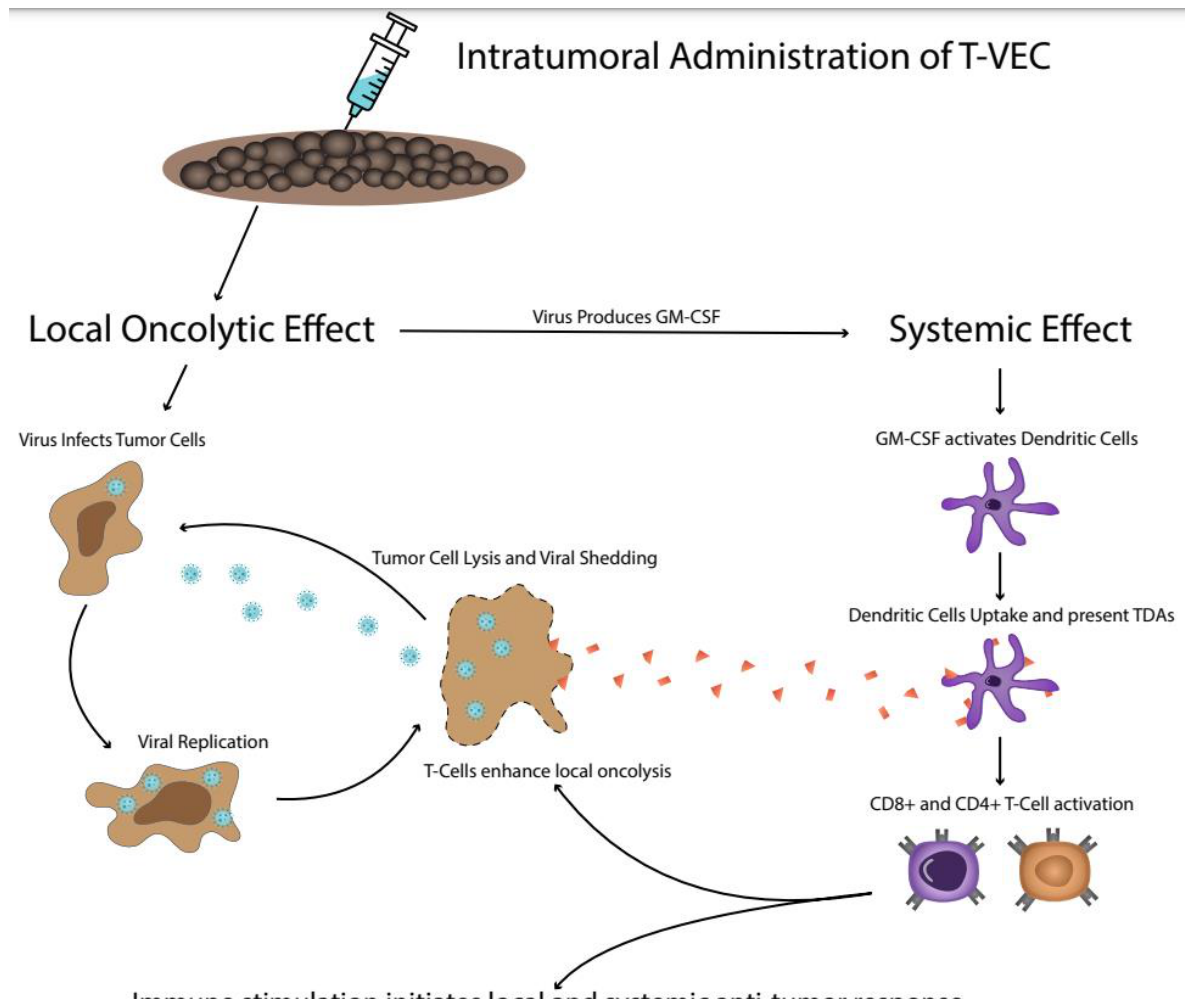
Figure 1. The dual anti-tumor mechanism of action of T-VEC. Initially, T-VEC infects tumor cells and replicates intracellularly, causing cell lysis and the release of TDAs. In addition to the local inflammation, the genetically-induced production of GM-CSF attracts and activates dendritic cells, which uptake the TDAs and activate CD4+ and CD8+ T cells, initiating a systemic anti-tumor re- sponse. T-VEC = Talimogene laherparepvec; TDAs = tumor-derived antigens; GM-CSF = granulocyte- macrophage colony-stimulating